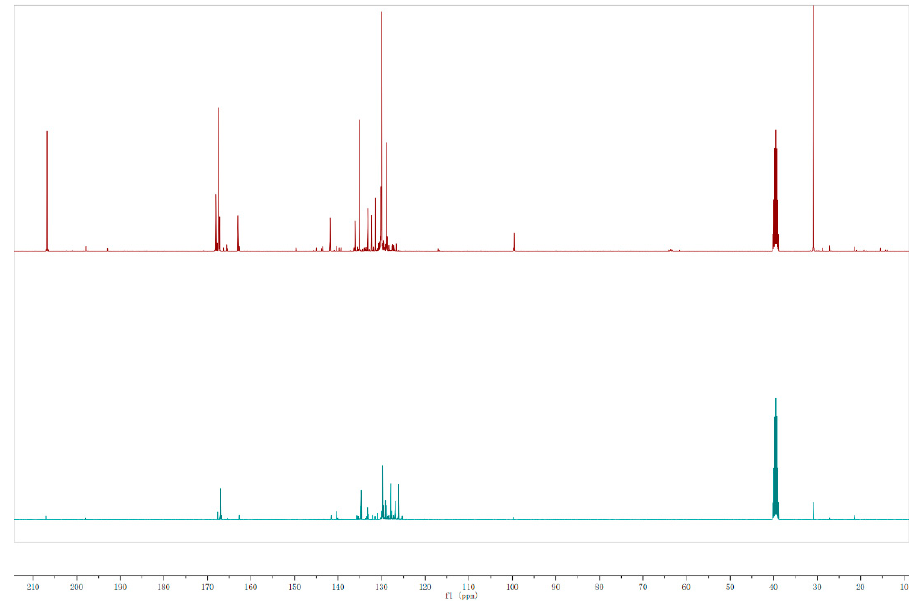
Figure 7. Quantitative 13 C NMR spectra for the waxy products produced by the thermal pyrolysis of PET ( top ) and catalytic fast pyrolysis with ZSM-5(1:2) as a catalyst ( bottom ) at 600 °C for 30 min.